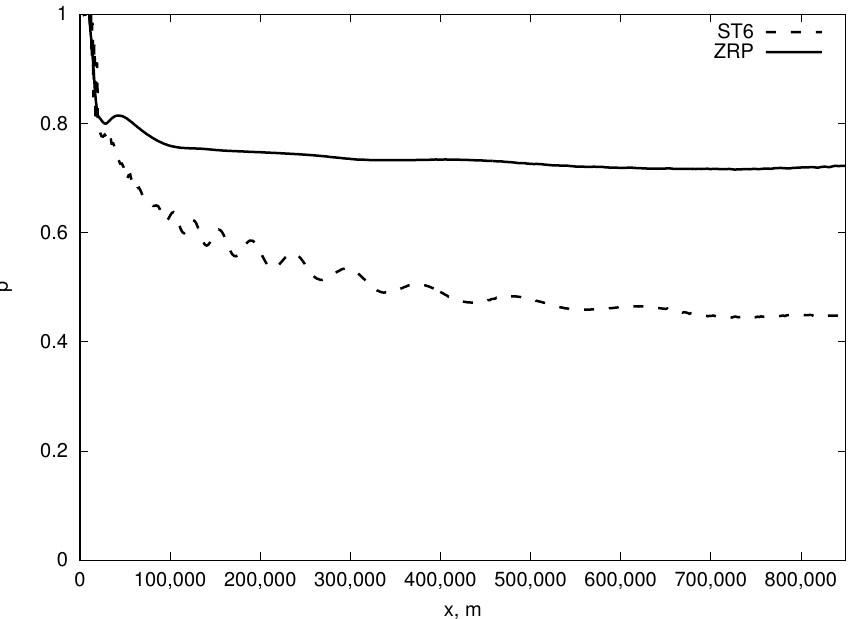
Figure 3. Total wave energy power-like local index p as the function of the dimensionless fetch.